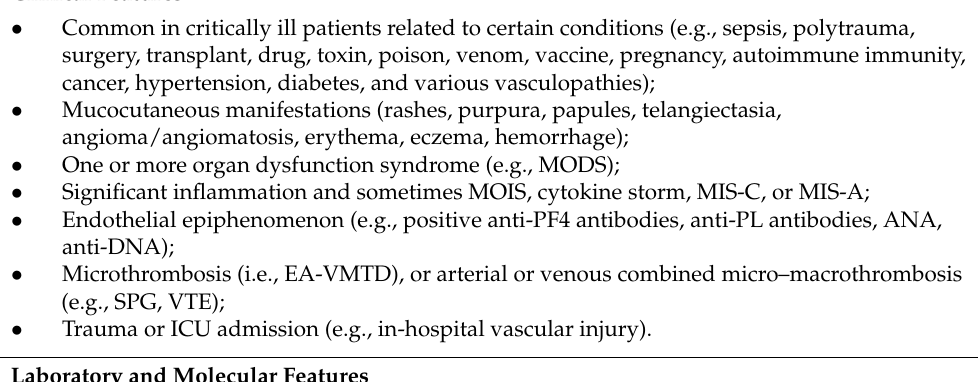
Table 5. Endotheliopathy: based on clinical, laboratory, and molecular characteristics. Clinical